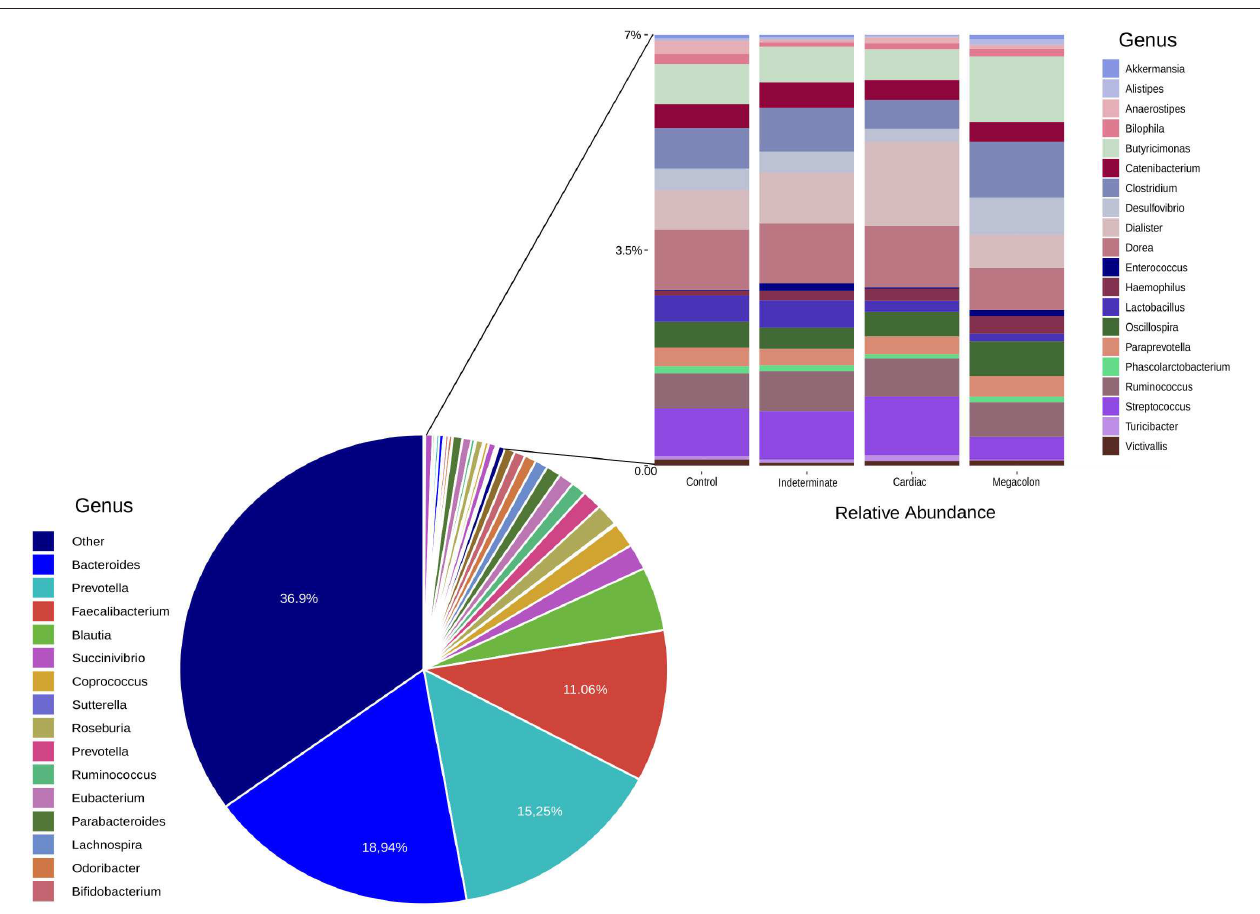
FIGURE 2 | Genera relative abundance (%) based plots. The left plot represents the average relative abundance detected in the stool samples of all the groups (control, indeterminate, cardiac, and megacolon) and the right least abundant genus ( < 7%).